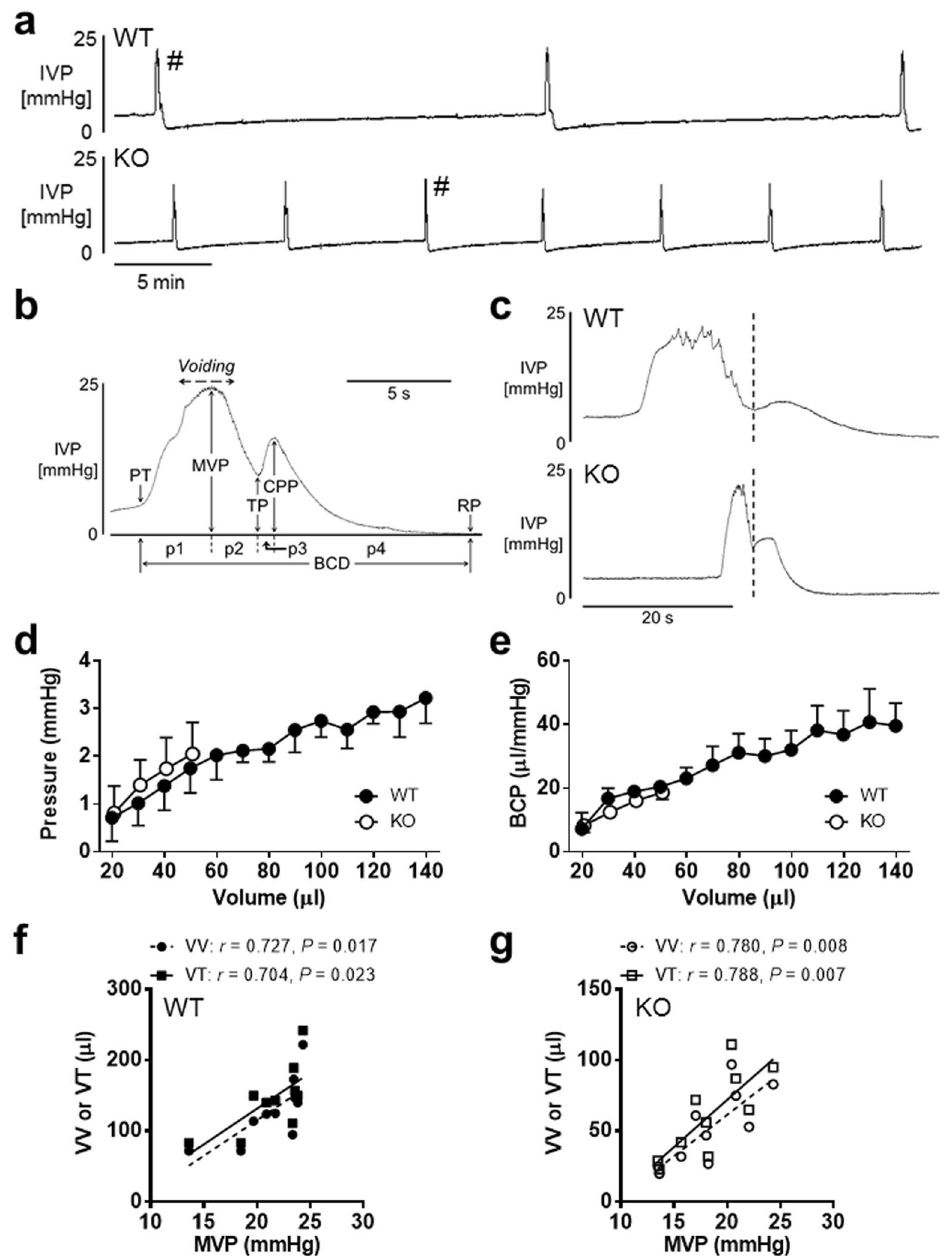
Figure 3. Cystometry analysis of reflex micturition cycle under decerebrate unanaesthetized conditions. ( a ) Bladder activity was recorded during continuous saline infusion cystometry (infusion rate: 10 µ l/min). Note that, compared with a WT mouse (top), a P2Y 6 -KO mouse (bottom) presents increased frequency of micturition. A bladder contraction was evaluated in detail as indicated in ( b ). PT, pressure at volume threshold for micturition contraction; MVP, maximal voiding pressure; TP, trough pressure; CPP, closing peak pressure; RP, post-void resting pressure; BCD, bladder contraction duration; p1, p2, p3, and p4 are 1st, 2nd, 3rd, and 4th phases of BCD, respectively. ( c ) A comparison of a WT mouse (top) and a P2Y 6 -KO mouse (bottom), both of which were extracted from micturition contractions with the symbol (#) in (top) and (bottom), respectively, showed that a contraction duration of the P2Y 6 -KO mouse is markedly shorter than that of the WT mouse. A dotted line divides a bladder contraction into the 1st phase duration and 2nd phase duration 24 . Pressure-volume relationship ( d ) and bladder compliance (BCP)-volume relationship ( e ) of WT and P2Y 6 -KO mice showed no difference between the 2 groups (by repeated measures two-way ANOVA) and indicate a linear regression in the relationships (Y = 0.01928X + 0.6188 and Y = 0.2527X + 7.658, respectively, for WT; Y = 0.04046X + 0.08669 and Y = 0.3496X + 1.633, respectively, for P2Y 6 -KO). These relationship graphs were constructed using animals that completed values of 20 µ l to 140 µ l for WT and 20 µ l to 50 µ l for P2Y 6 -KO (n = 6 for each group). Coefficients (r) and P values (P) between MVP and VV or VT for WT ( f ) and P2Y 6 -KO ( g ) are shown (n = 10 for each group), based on the calculation by Spearman’s correlation analysis and by Pearson’s correlation analysis, respectively. VV, voided volume; VT, volume threshold for micturition